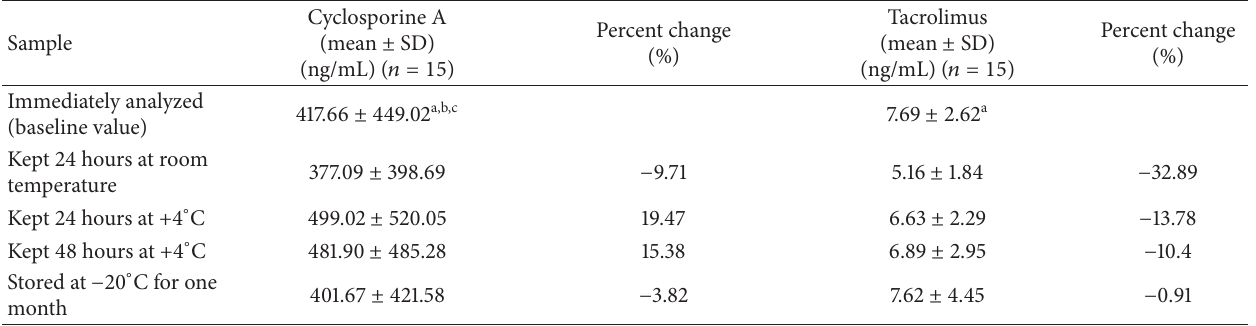
Table 1: The cyclosporine A and tacrolimus levels of the samples stored under different storage conditions.